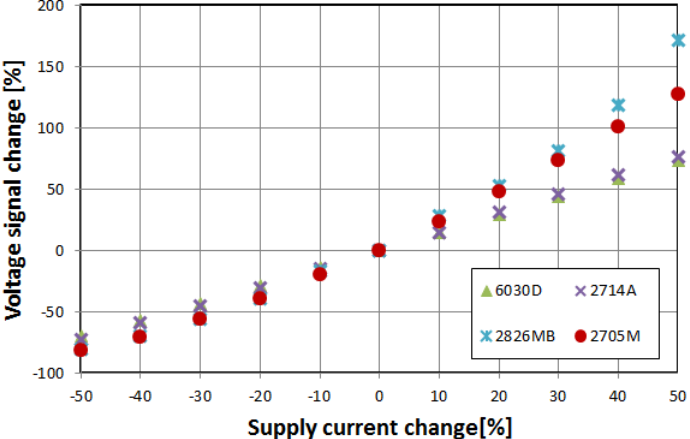
Figure 7. Relative change of the induced e 2f voltage in the function of supply current change, and thus proportional exciting H ⊥ field change.